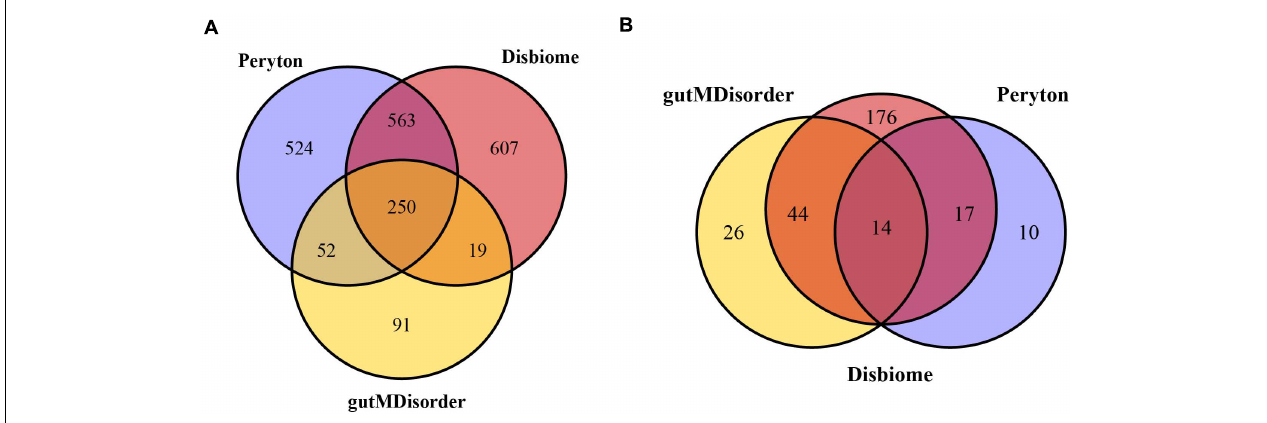
FIGURE 1 | Venn diagram of overlapping microbes (A) and diseases (B) from the Peryton, Disbiome, and gutMDisorder